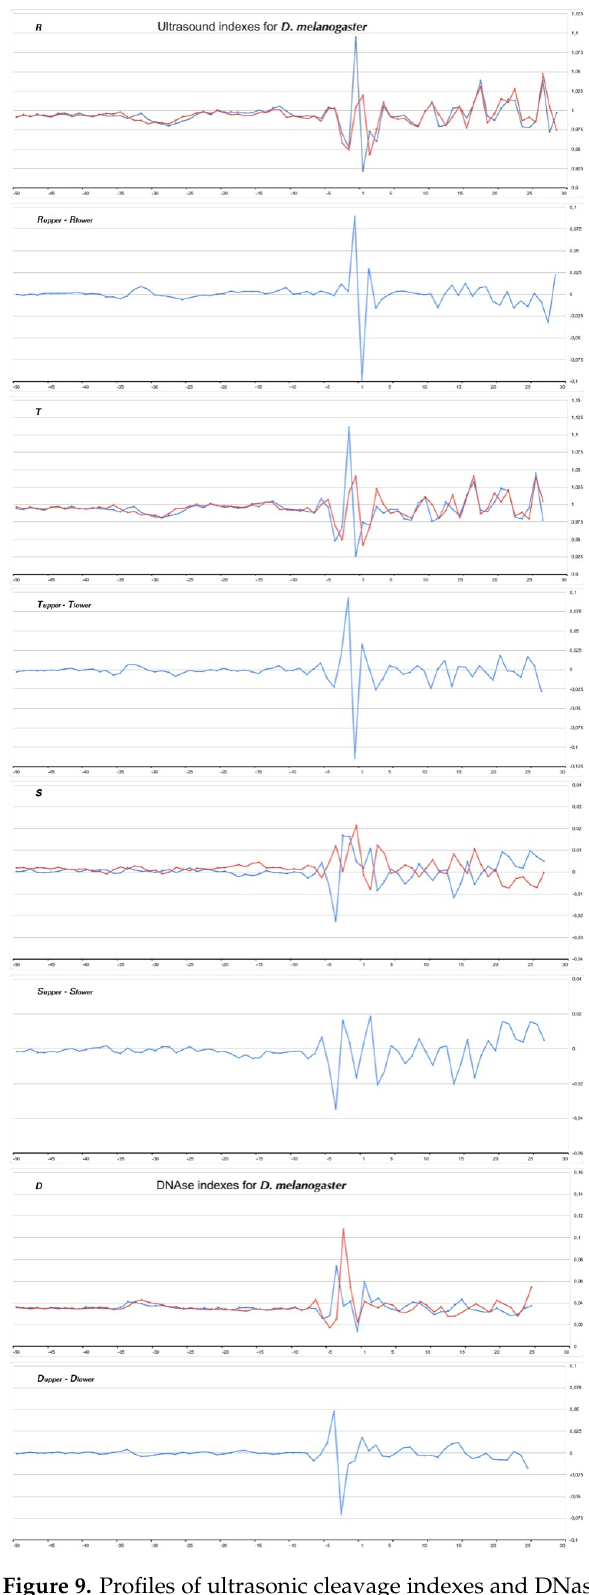
Figure 8. Profiles of ultrasonic cleavage indexes and DNase I cleavage indexes for H. sapiens core promoters.